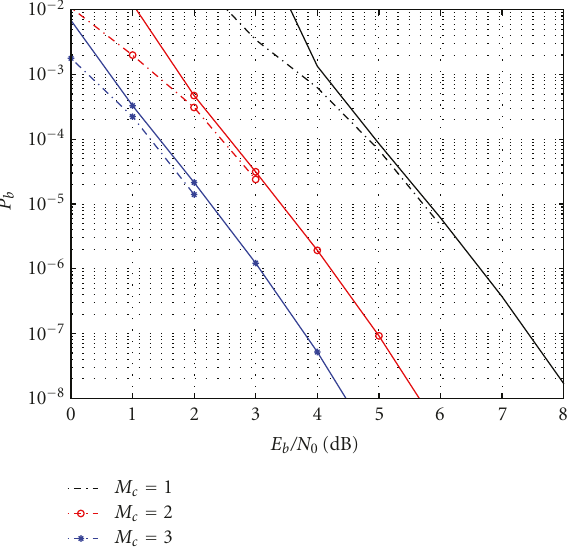
Figure 5: Bit-error probability of 8PSK TCM-coded GSC with M = 4 in Nakagami fading with m = 4 (solid: bound, dashed: